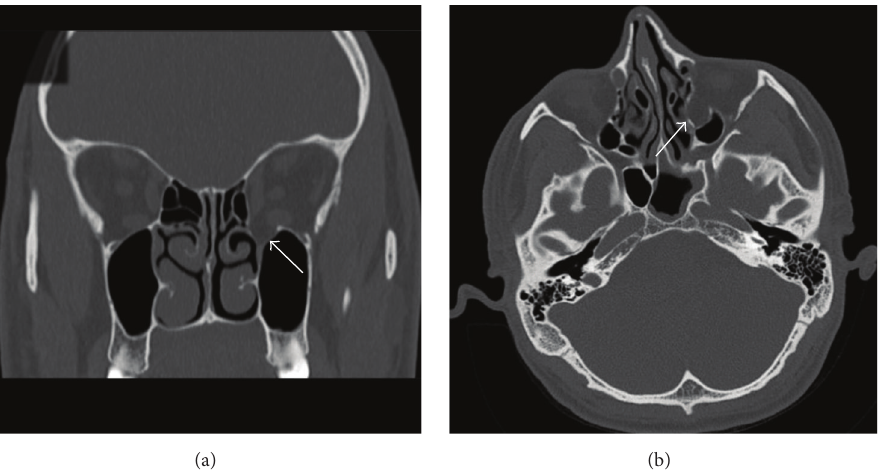
Figure 2: Coronal (a) and axial (b) CT scans showing the old dislocated fracture of the left medial orbital floor and wall.